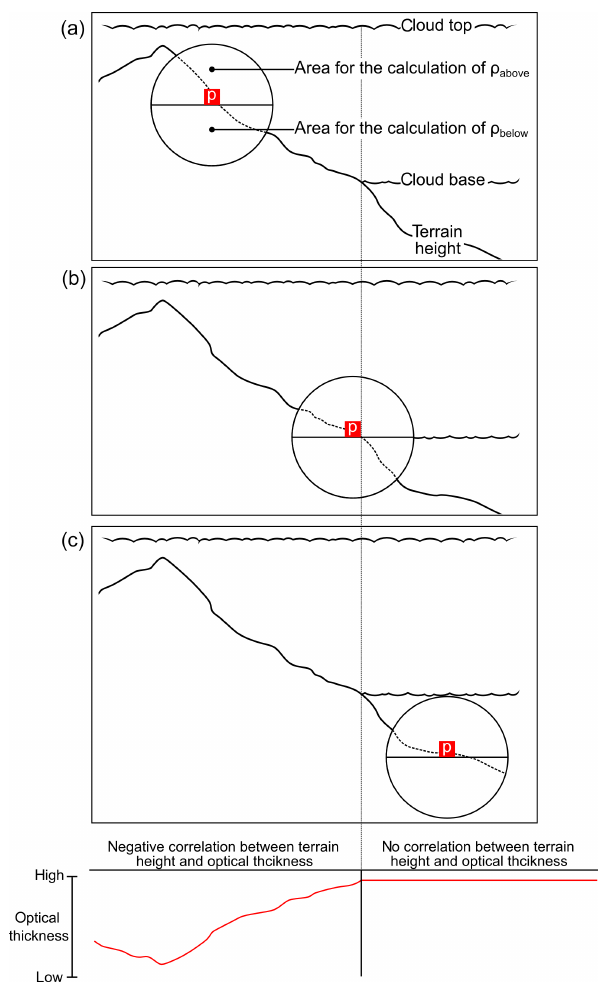
Figure 5. The calculation of ρ diffp for pixels p in different loca- tions. (a) Inside a cloud, ρ abovep and ρ belowp are calculated from pixels with ground fog. Therefore both values are clearly negative. This results in a small ρ diffp . (b) At the cloud base height, ρ abovep is calculated from pixels with ground fog. It is therefore clearly negative. ρ belowp is calculated from pixels without ground fog. Its value is therefore close to 0. This results in a high ρ diffp . (c) Be- low a cloud, ρ abovep and ρ belowp are calculated from pixels with- out ground fog. Therefore both values are near to 0. This results in a small ρ diffp